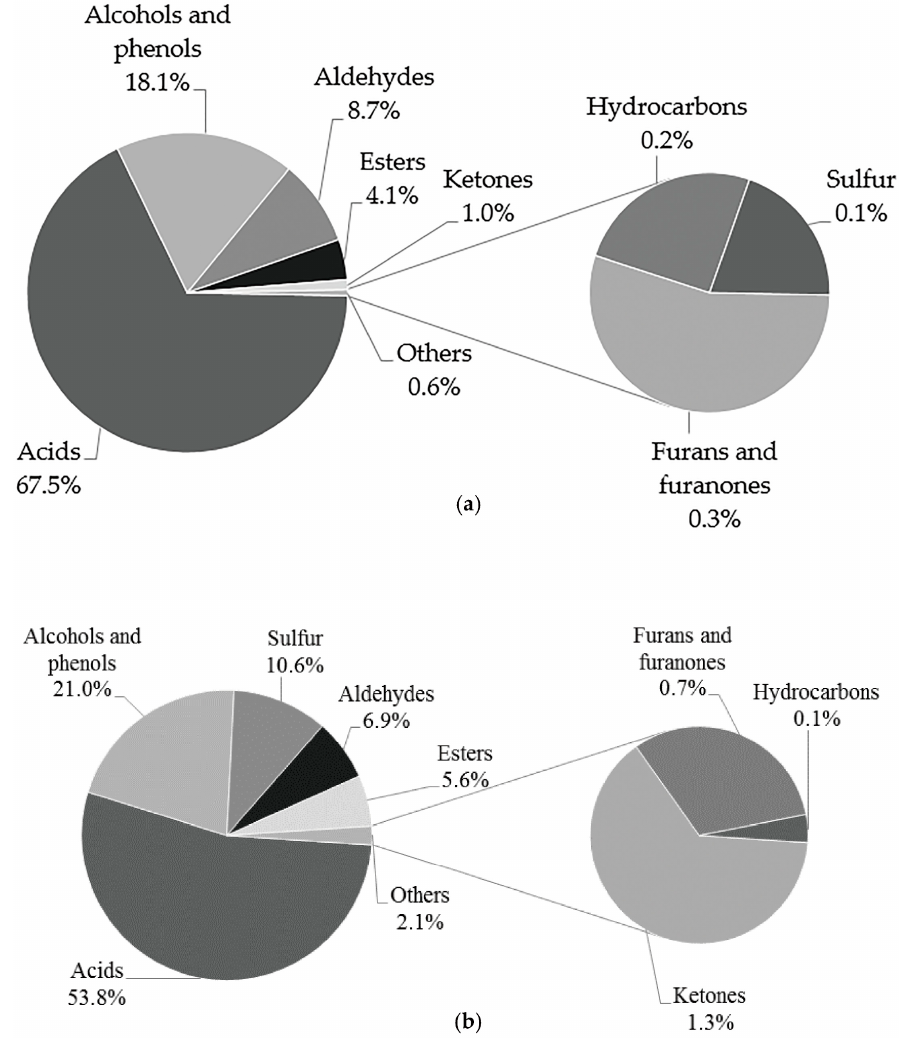
Figure 2. Variability of the compositions in fruiting bodies of BT ( a ) and WT ( b ) based on concentrations.